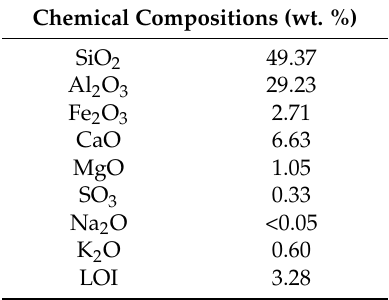
Table 1. Chemical composition of fly ash.